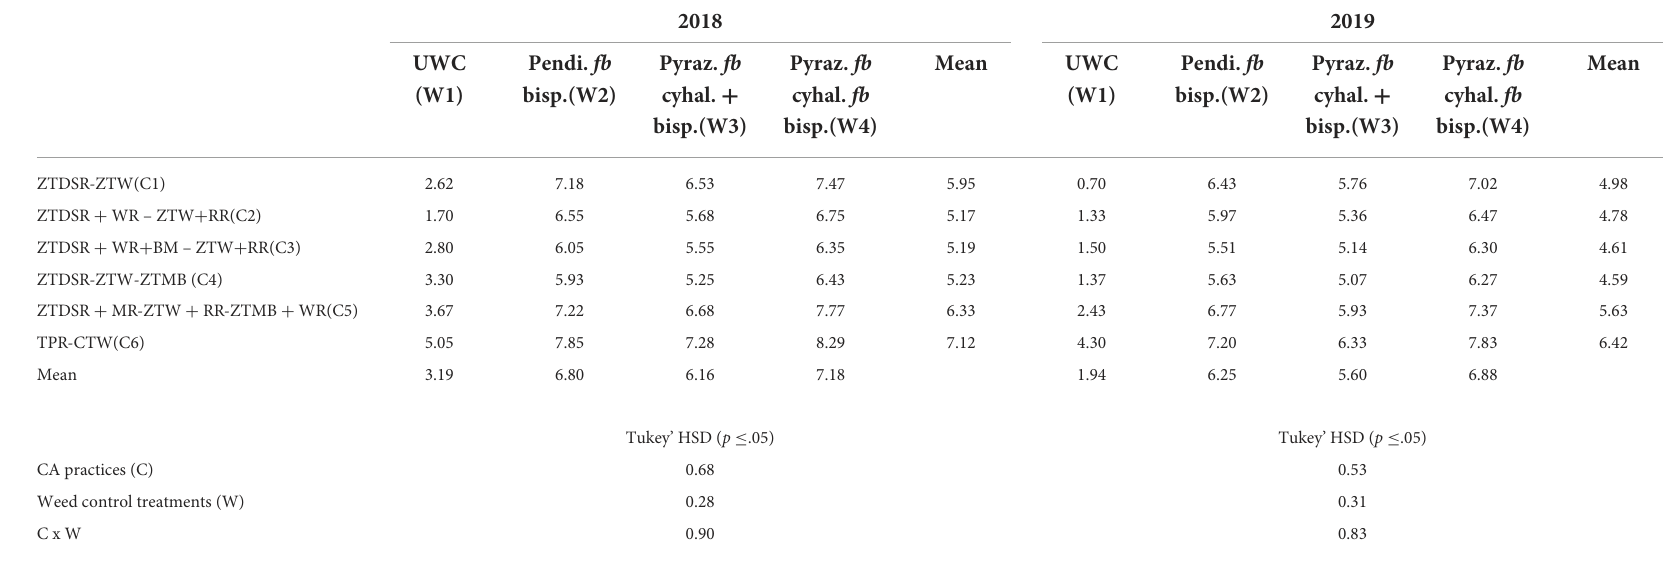
TABLE 10 Interaction between CA and weed control/herbicides treatments on grain yield of rice (t ha − 1 ) in 2018 and